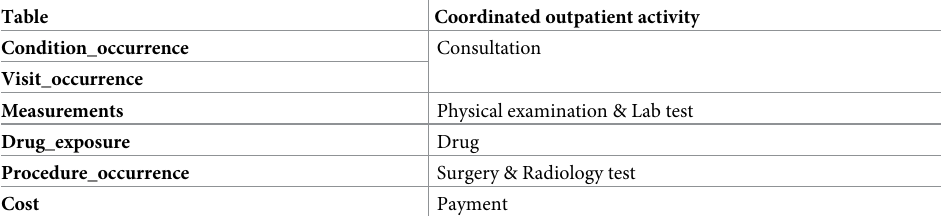
Table 2. Available outpatient activities derived from CDM. Table